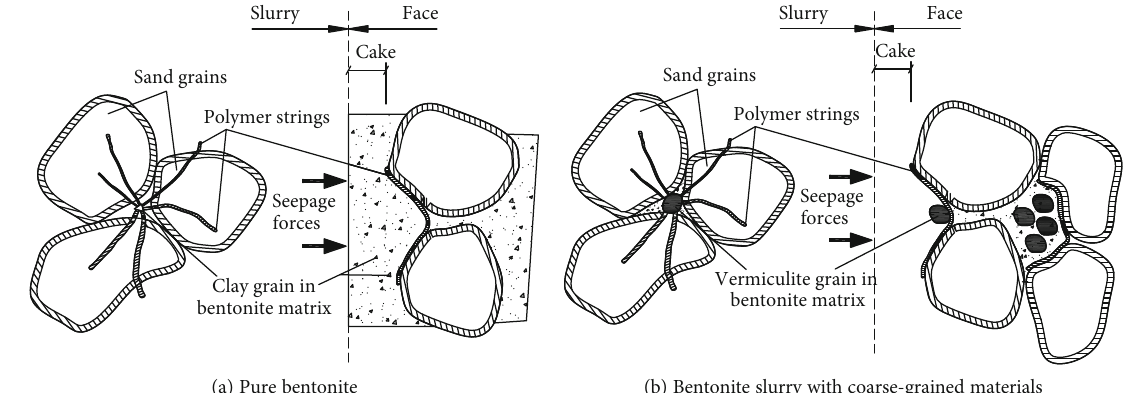
Figure 6: Filter cake formation mechanism